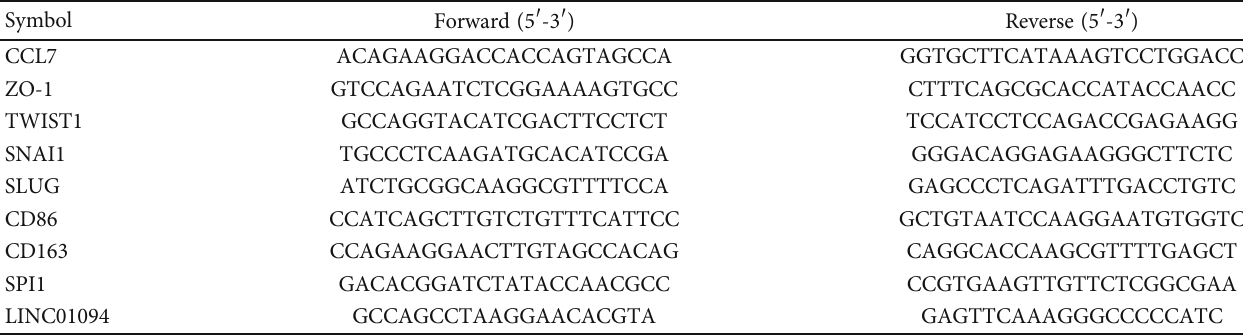
Table 2: Primer sequences for qPCR analysis.